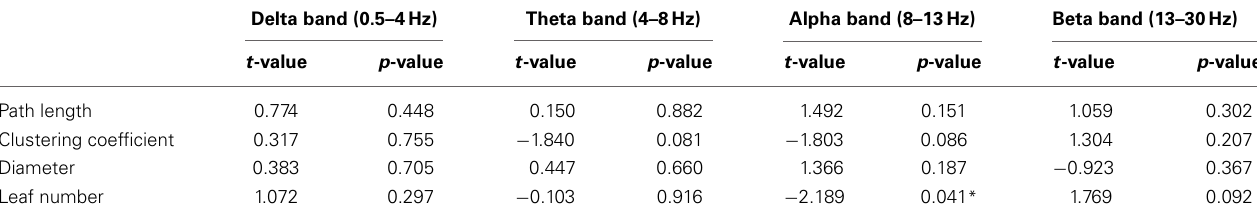
Table 3A | Paired t -test between EEG and SD-EEG recordings of patients for network measures (path length and clustering coefficient) and MST measures (diameter and leaf number).